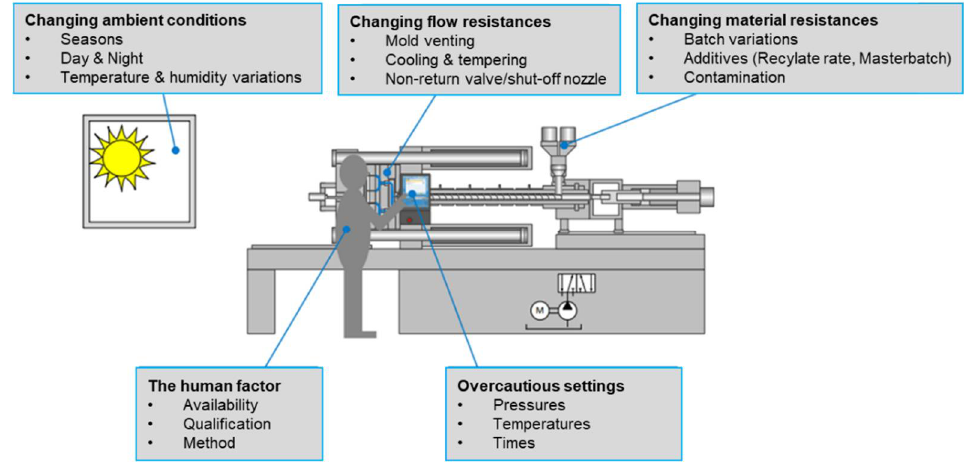
Figure 1. Factors affecting the product weight in the injection molding process [1].